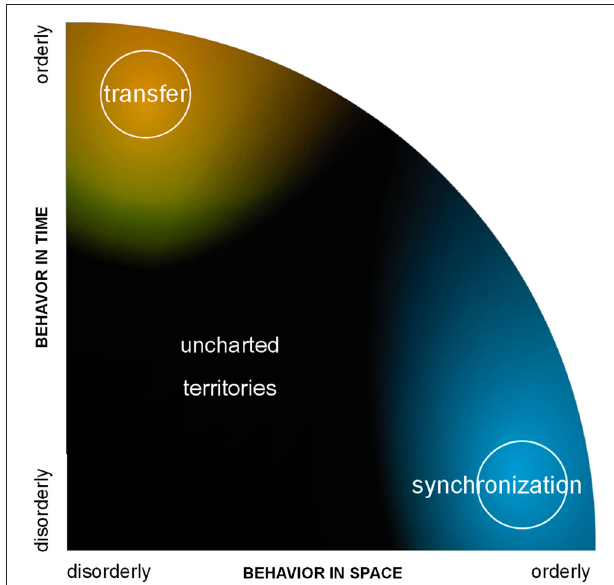
FIGURE 2 | A graph of spatiotemporal organization. The horizontal axis quantifies the degree of order in space; order in time is on the vertical axis. Examples of orderly phenomena are propagation and synchronization. There are numerous hints that the brain is more efficient with less than complete order in space and time. The dark area represents this region with incomplete spatial and temporal order, for which concepts and tools are sorely